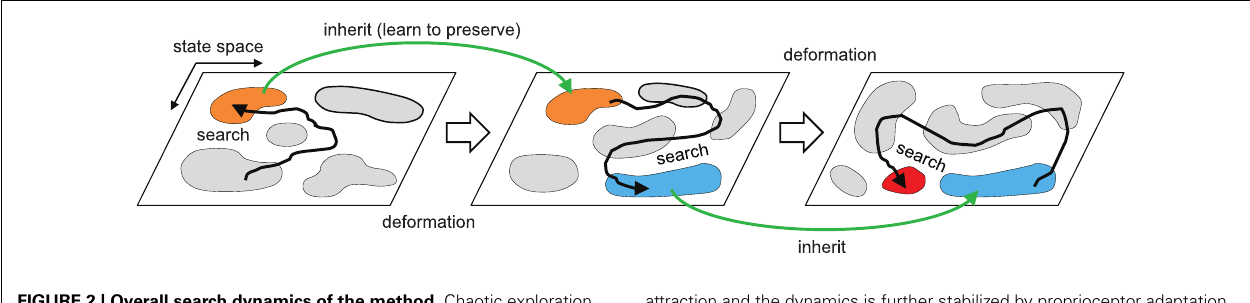
FIGURE 2 | Overall search dynamics of the method . Chaotic exploration samples the population of attractors (motor patterns) that describe the intrinsic dynamics of the embodied system by driving the system orbit through the state space.The orbit is entrained in a high performing basin of